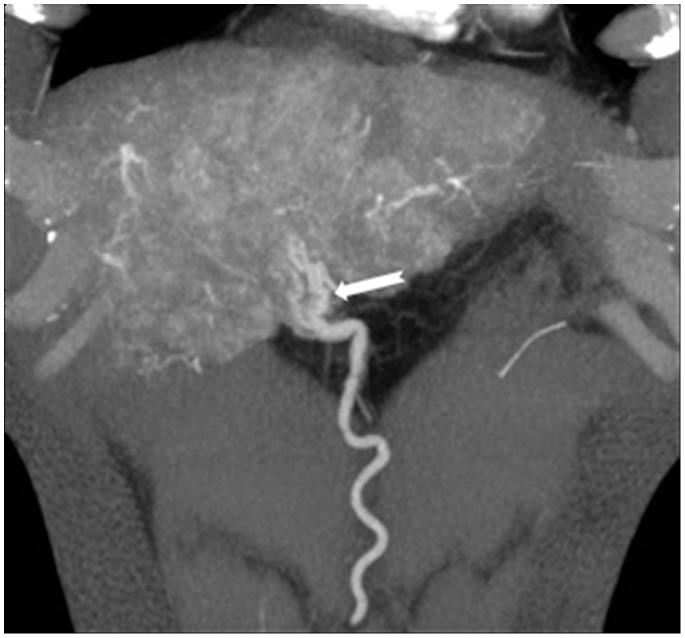
In a 59-year-old man with hepatocellular carcinoma with S5 and S8, abdominal wall artery participates in blood supply for the carcinoma.Maximum intensity projection displays that a large, twist branch of abdominal wall artery enter the tumor (white arrow).